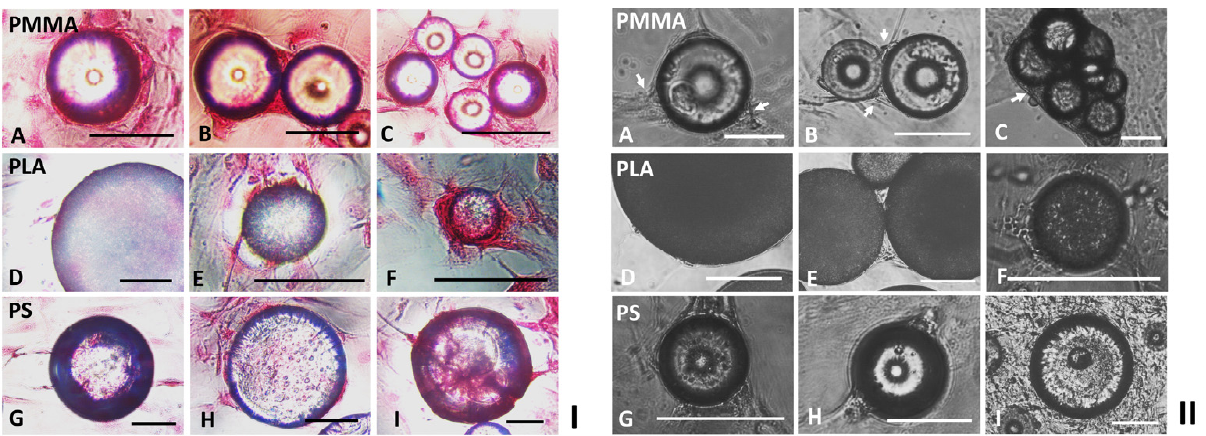
Figure 2. ( I ) Sirius red staining of HDFs cultured on the spherical modular scaffolds. HDFs cultured for 2–6 days in tissue culture plates with ( A – C ) PMMA, ( D – F ) PLA or ( G – I ) PS particles were fixed with 70% ethanol, stained with Sirius red, analyzed via phase contrast microscopy (PCM). (scale bar = 100 µm). ( II ) The influence of different polymeric particles on the cells cultured on the flat surfaces of 24-well culture plates. HDFs cultured for more than 6–10 days in the tissue culture plates with ( A – C ) PMMA, ( D – F ) PLA or ( G – I ) PS particles were analyzed via PCM. The cells peeled off by PMMA particles from the flat plate surfaces are highlighted via White arrows. (scale bar = 100 µm).